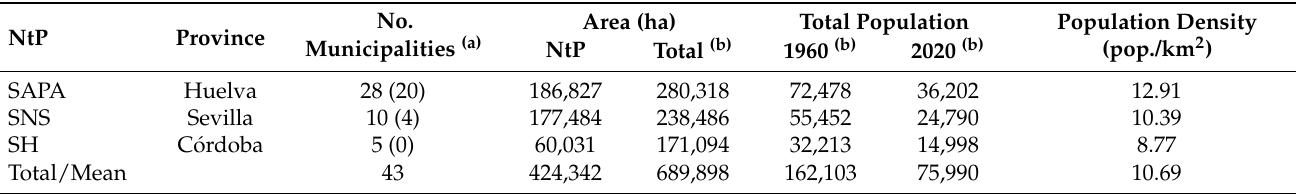
Table 2. General data of the natural parks.